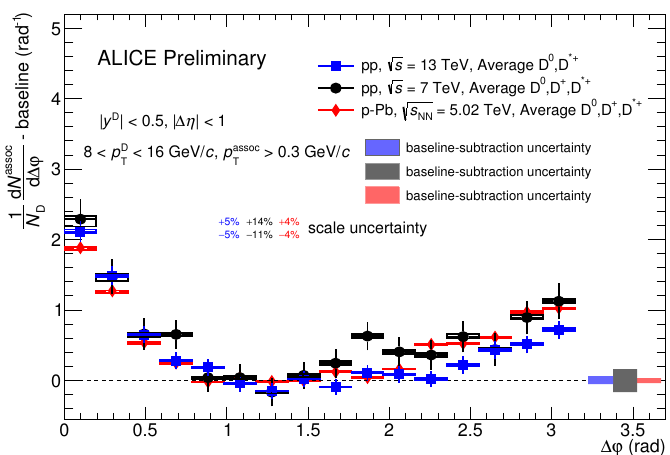
Figure 1. Average azimuthal correlations of D-mesons with charged particles measured in pp collisions √ s = 13 TeV compared with those obtained in pp collisions at at √ s NN = 5.02 TeV (with subtracted baseline) for the D-meson p T range 8 − 16 GeV/ c and charged at particle p T > 0.3 GeV/ c